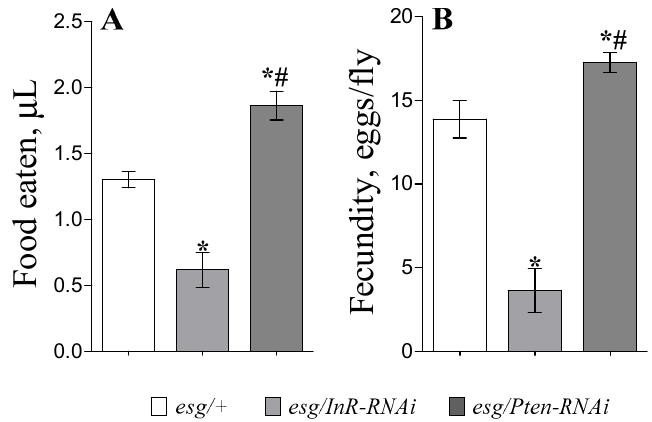
Figure 2. Daily food consumption ( A ) and number of eggs laid daily per female ( B ) for flies with IIS, either activated or inhibited in esg- cells. Results are presented as mean ± SEM, with 10–20 flies tested per genotype. The experiments started after six days of expression induction at 29 °C and were performed over four days. Due to their reduced lifespans, esc/InR-RNAi genotype flies were tested ones; thus, bars present results of single-day measurements. Group comparisons were performed using ANOVA followed by Newman–Keuls post hoc test. Asterisks indicate significant difference from control flies ( esg/+ ) ( p < 0.05); hash signs show significant difference from flies with inhibited IIS ( esg/InR-RNAi ).